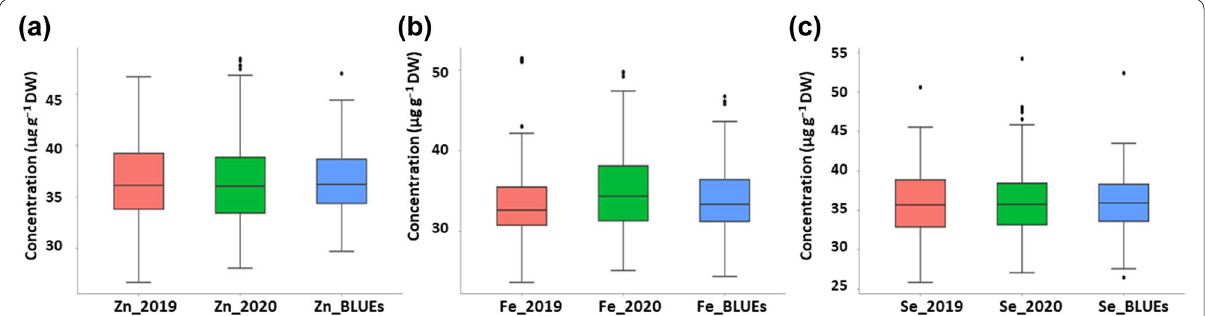
Fig. 1 Box plots of genotypes for each year (2019/2020) and BLUEs in spring barley; a Zn concentration, b Fe concentration and c Se